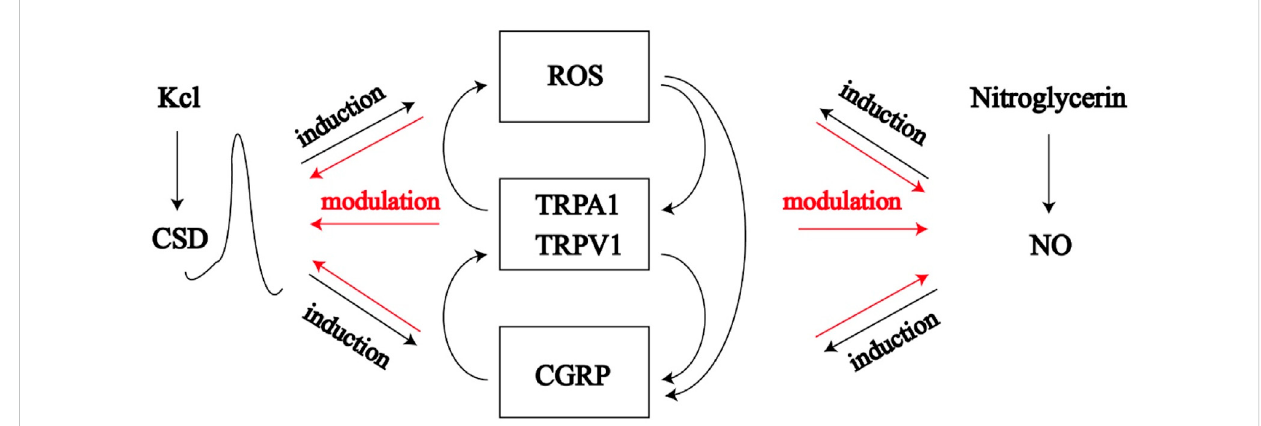
FIGURE 1 Cortical spreading depression inducedby potassium chlorideand nitric oxide release induced by nitroglycerin can affect ROS/TRPA1/TRPVA/CGRP pathway, which forms positive feedback with CSD and NO, which leads to energy metabolism disorder and